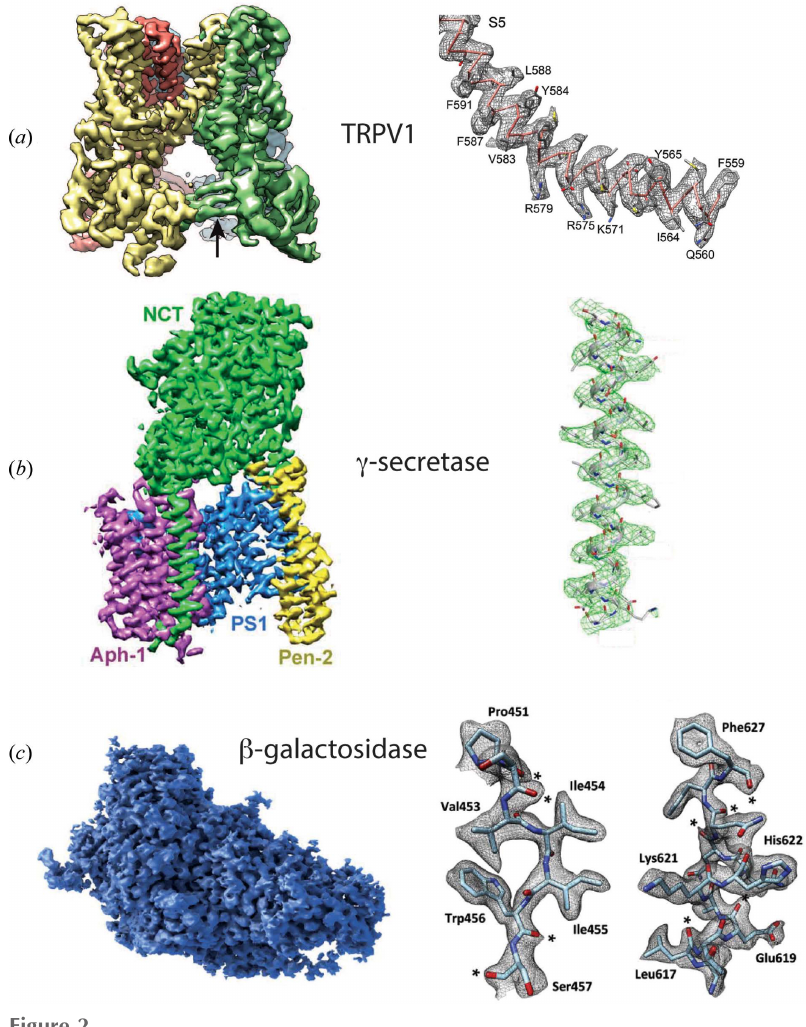
Figure 2 Selected examples of structures with sizes below 500 kDa. ( a ) TRPV1 temperature-sensing channel also called the capsaicin receptor (Liao et al. , 2013) at 3.4 A˚ resolution, ( b ) (cid:2) - secretase at 3.4 A˚ resolution (Bai et al. , 2015) and ( c ) (cid:3) -galactosidase at 2.2 A˚ resolution (Bartesaghi et al. , 2015). Not on same